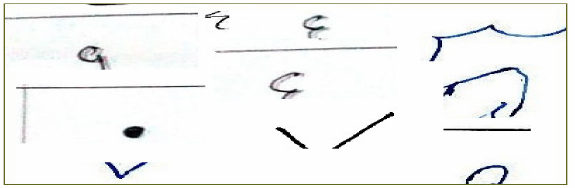
Figure 5. Discarded images.